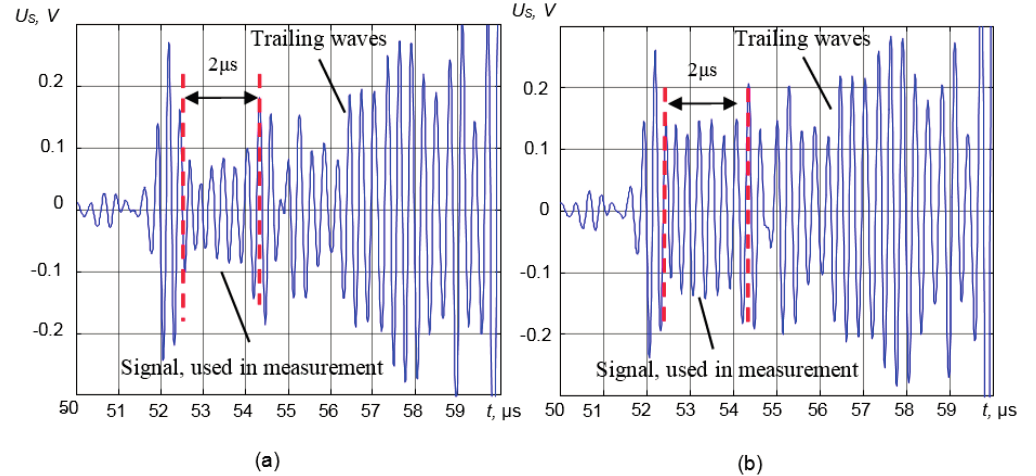
Figure 13. Time diagrams of the measured signals reflected by the interface waveguide-liquid and received by the ultrasonic transducer in the case of the steel waveguide with the aluminum powder matching layer with different loads: ( a ) distilled water; ( b ) ethyl ether. The amplitude of the signal U rw reflected from the distilled water at known temperature was found from the signal spectrum at the frequency f 0 . The reflection coefficient R 3 ( f 0 ) at this frequency should be minimum. In this case, the obtained U rw ( f 0 ) was used as the reference value according to Equation (6). All other density measurements are made with respect to the density measurement in the distilled water. It should be mentioned that this procedure enables reducing measurement errors due to the drift of electronic units of the measurement